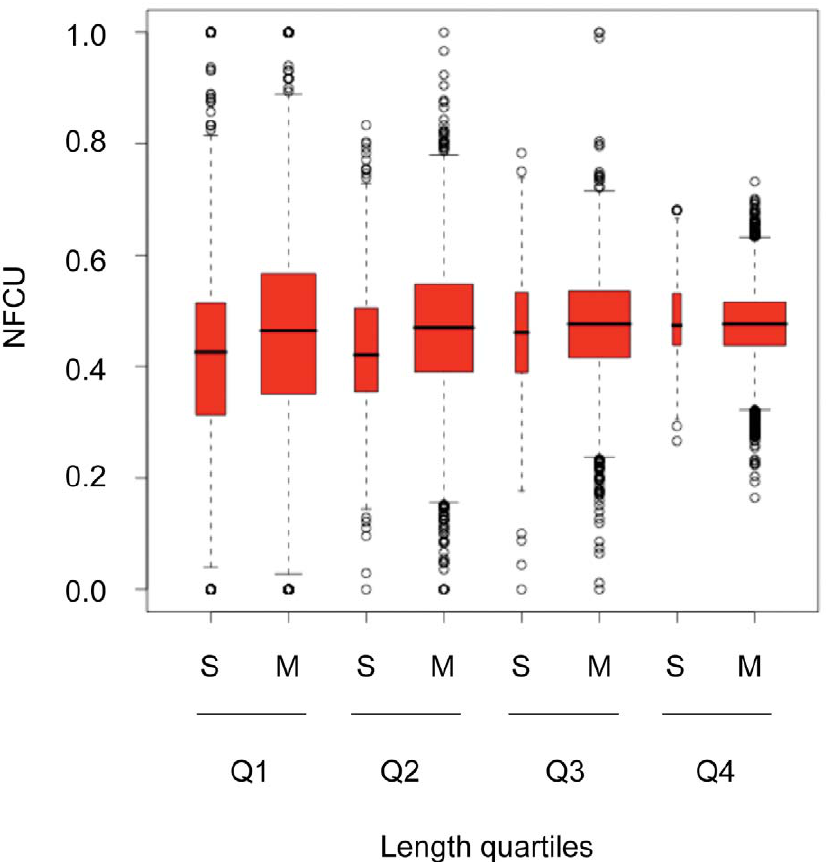
Figure 4. Fragile codon depletion is not due to reduced efficiency of PABP–dependent NMD in shorter mRNAs. Normalized fragile codon usage (NFCU) of human single- (S) and multi-exon (M) genes binned by transcript CDS length. For each quartile of transcript length (Q1, shortest, to Q4, longest) NFCU for single and multi-exon genes is plotted separately. The width of each bin is proportional to the square root of the number of genes it